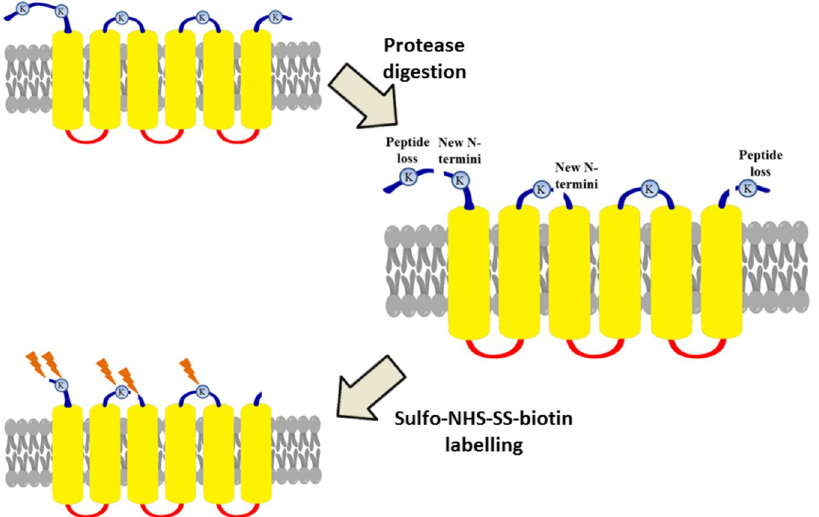
Figure 1. Protease treatment of TMPs to reveal new extracellular segments that can be labelled by biotinylation agents. Representation of extracellular Sulfo-NHS-SS-biotin labelling on a pre-digested model TMP (the colours of TMP based on topology: yellow: transmembrane segments, blue: extracellular parts and red: intracellular parts, orange lightning: Sulfo-NHS-SS-biotin and grey: phospholipid bilayer). After pre-digestion, new N-termini and accessible lysine (K) residues arise and can be labelled with Sulfo-NHS-SS-biotin.